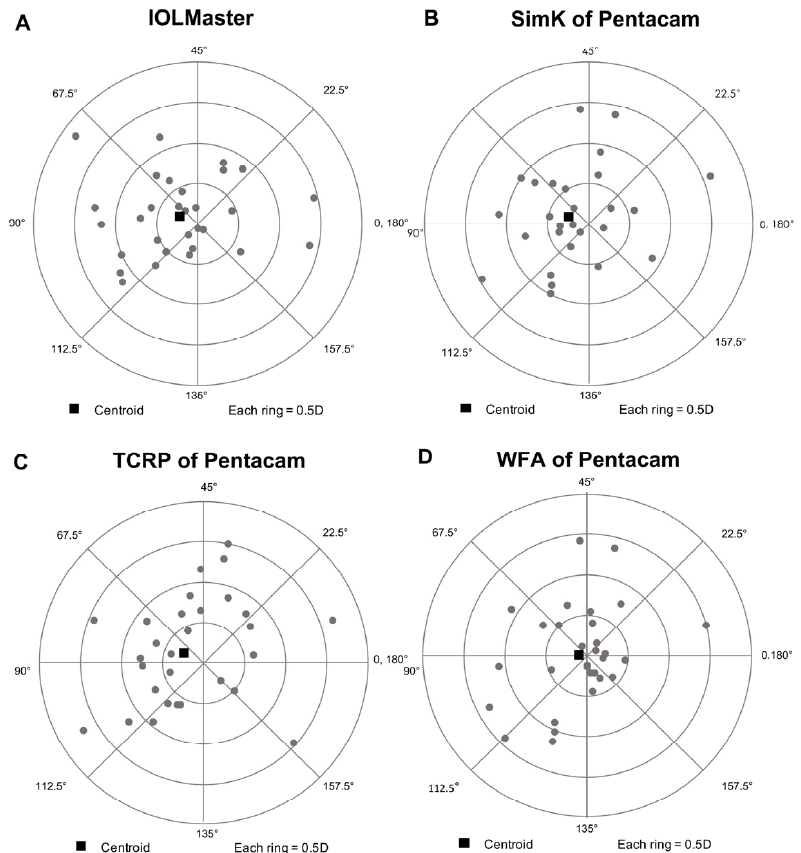
Figure 3. Double-angle plots of corneal astigmatism prediction errors in eyes, measured with the four different measurement modes: ( A ). IOLMaster; ( B ). Pentacam SimK mode; ( C ). Pentacam TCRP mode; ( D ). Pentacam WFA mode. The centroid prediction errors of the four modes were 0.23 D@80°, 0.25 D@80°, 0.26 D@78°, and 0.10 D@88°, respectively. SimK, simulated keratometry; TCRP, total corneal refractive power; WFA, wavefront aberration.